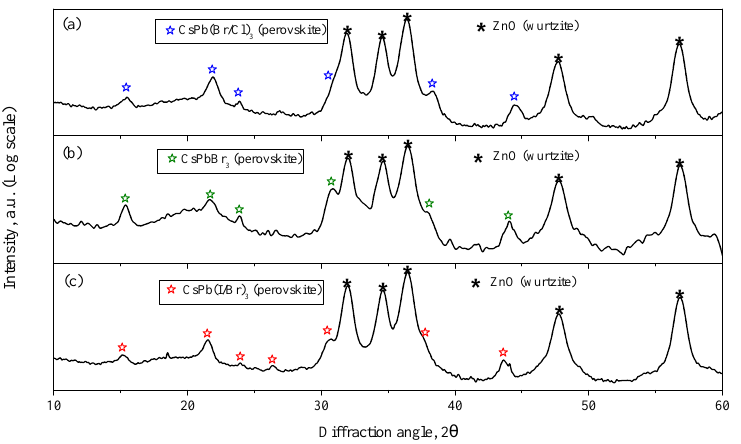
Figure 7. XRD patterns of ZnO/CsPb(Cl/Br) 3 ( a ), ZnO/CsPbBr 3 ( b ) and ZnO/CsPb(Br/I) 3 ( c ) nanocomposites. Due to the large difference in peak intensity between ZnO and PNCs, the in- tensity is plotted on a logarithmic